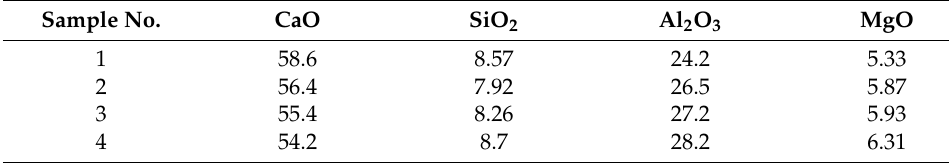
Table 2. Chemical compositions of slag (mass